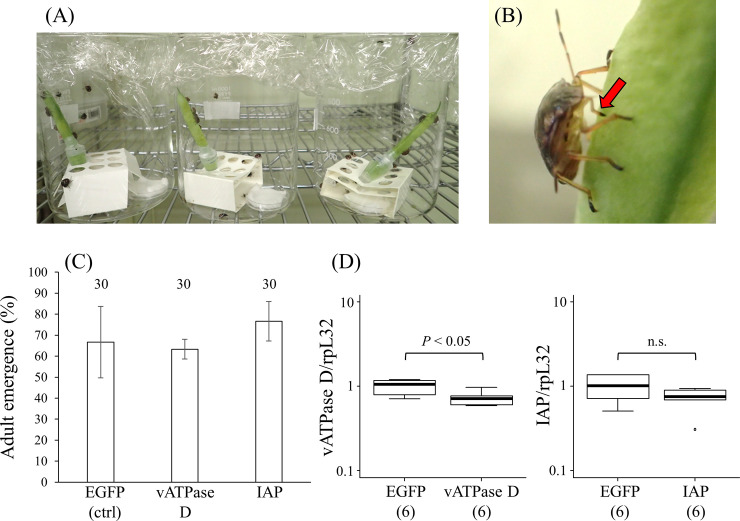
RNAi by feeding through green bean pods.(A) Rearing devices with green bean pods. In each 1000 ml beaker, a bean pod was supported to stand with a small paper box and immersed in dsRNA solution with absorbent cotton, on which newly molted fifth-instar nymphs were reared. (B) A fifth-instar nymph feeding on a green bean pod. Red arrow indicates the stylet inserted into the pod. (C) Adult emergence rates of fifth-instar nymphs fed on green bean pods immersed in dsRNA solution. Mean adult emergence rates with standard deviations are shown. Adult emergence rates among 10 nymphs were determined. The experiment was performed in three parallels and the mean adult emergence rates with standard deviations are shown. Numbers above bars show total sample sizes. No statistically significant differences were observed (P > 0.05, t-test). (D) Gene silencing efficiency of orally-delivered dsRNA through green bean pods. Total RNAs were extracted 4 days after treatment of fifth-instar nymphs, and the relative expression level of PsvATPase subunit D or PsIAP to PsrpL32 was calculated by quantitative RT-PCR. The numbers in parentheses are sample sizes. Statistically significant differences were evaluated by t-test.